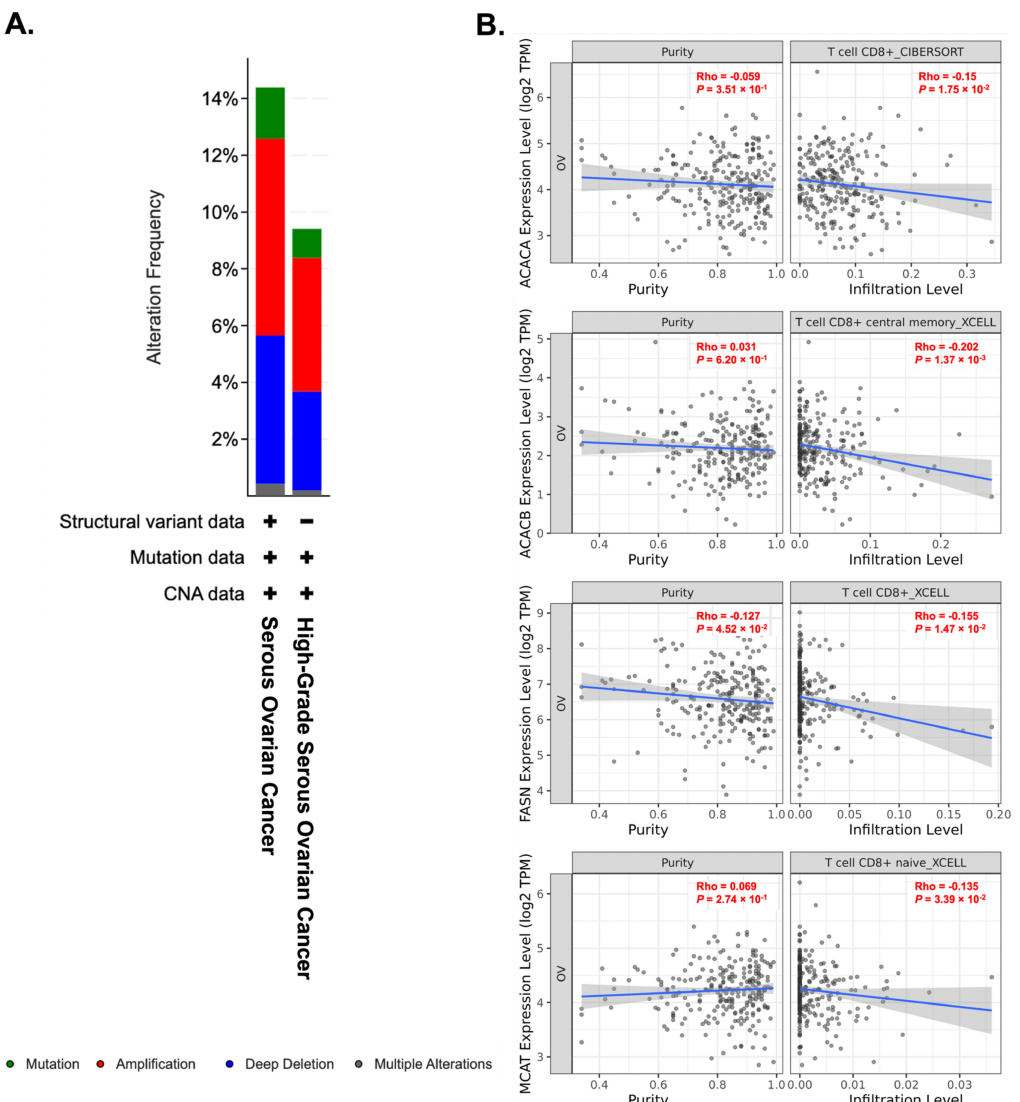
Figure 3. Targeting lipogenesis may exert beneficial effects in alleviating the impaired immune cell infiltration. ( A ) By means of the cBioPortal online tool, the genetic alterations of different lipogenic enzymes such as ACACA, ACACB, FASN, and MCAT in ovarian cancer patients were analyzed and summarized in the bar chart. Amplification alteration was the most frequently detected genomic alteration among serous subtypes of ovarian cancer. ( B ) Inverse correlations between differential expression of different lipogenic enzymes and abundance of CD8 + T cell infiltration in ovarian cancer by TIMER algorithm using datasets from Cibersort and